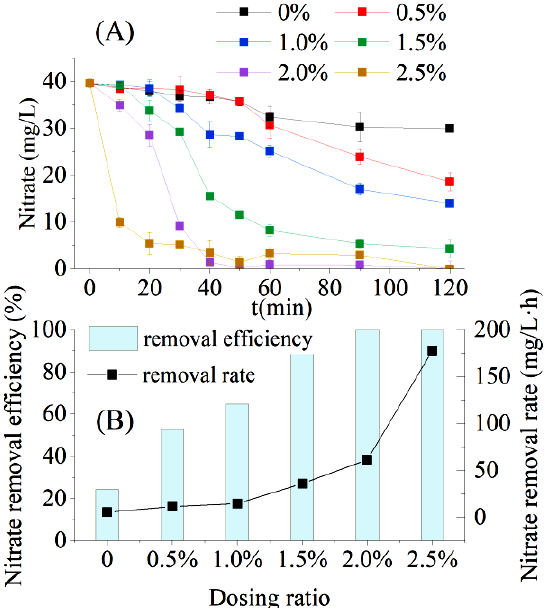
Figure 5. Performance of bagasse-enhanced aerobic denitrification (AD) flora in low C/N wastewater treatment. ( A ) Changes in nitrate concentration under different dosing ratios; ( B ) nitrate removal efficiency and nitrate removal rate under different additive